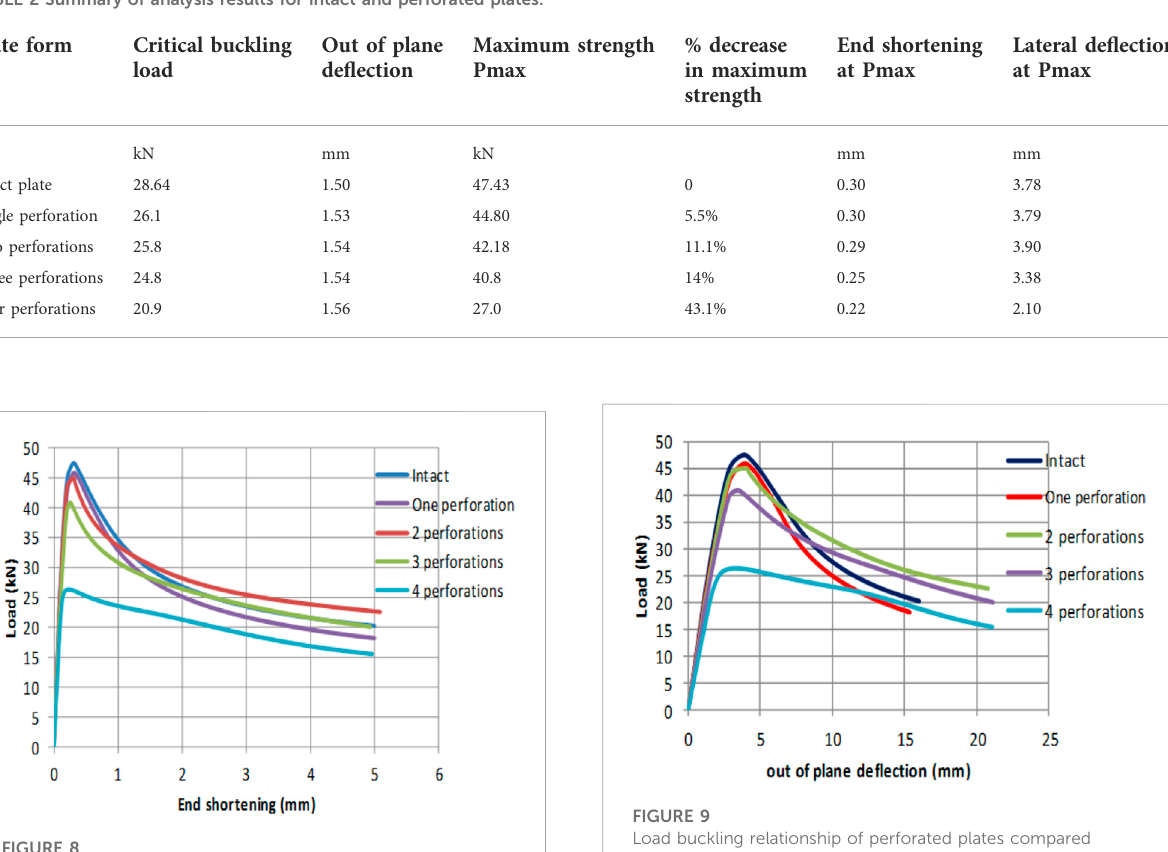
TABLE 2 Summary of analysis results for intact and perforated plates.